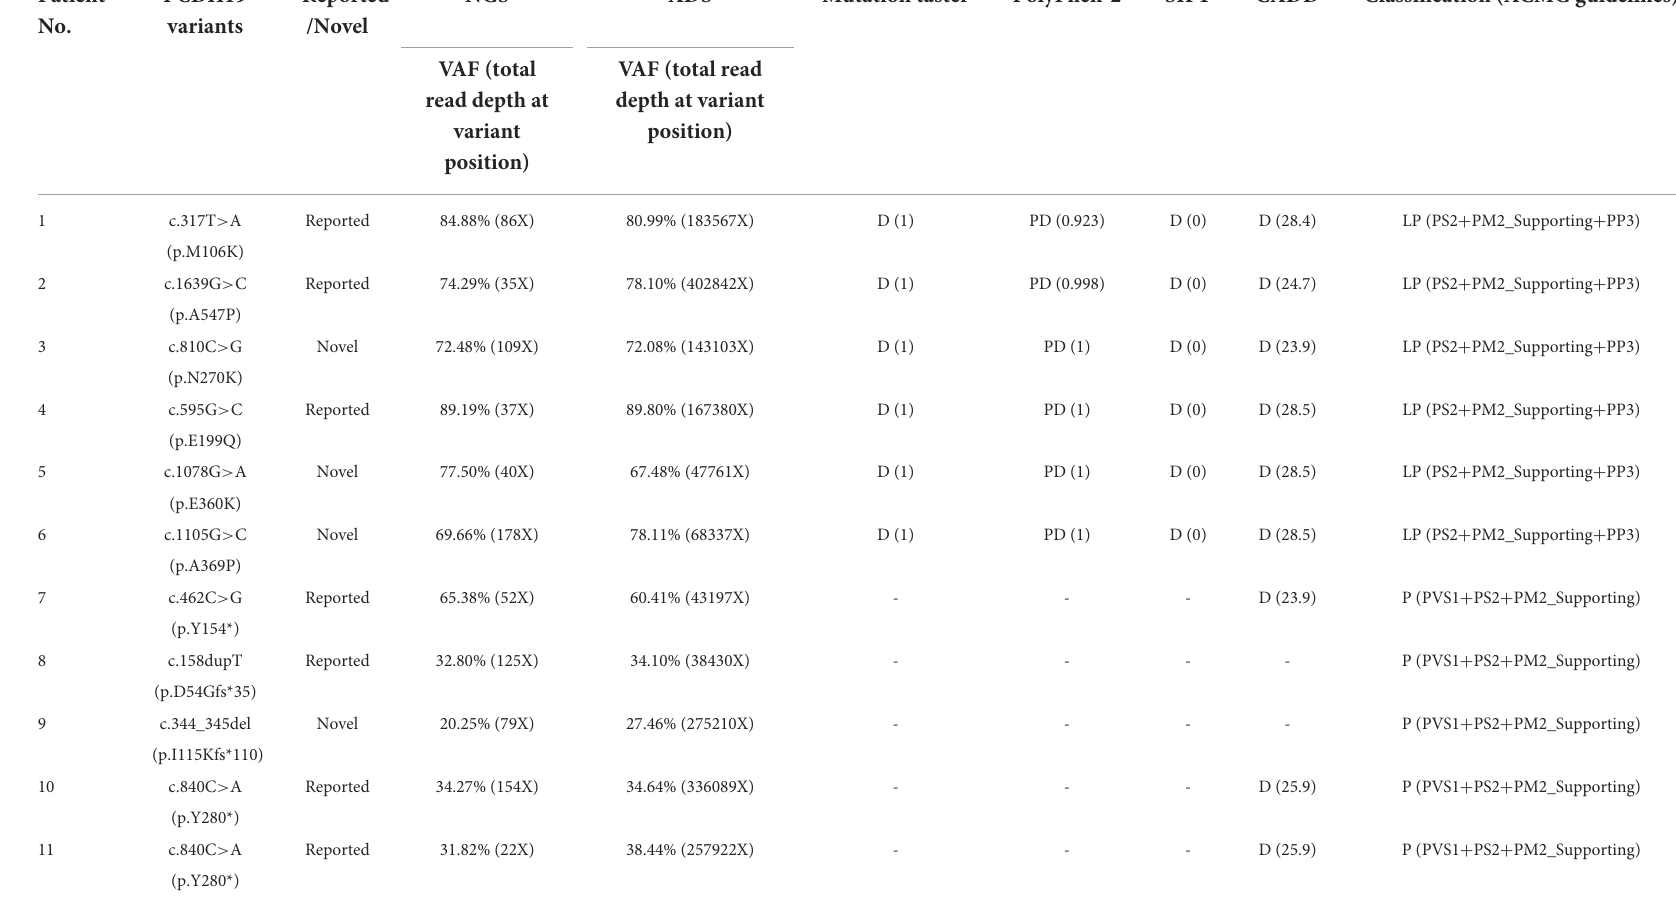
TABLE 1 Detection results and pathogenicity assessment of PCDH19 variants in 11 male epileptic